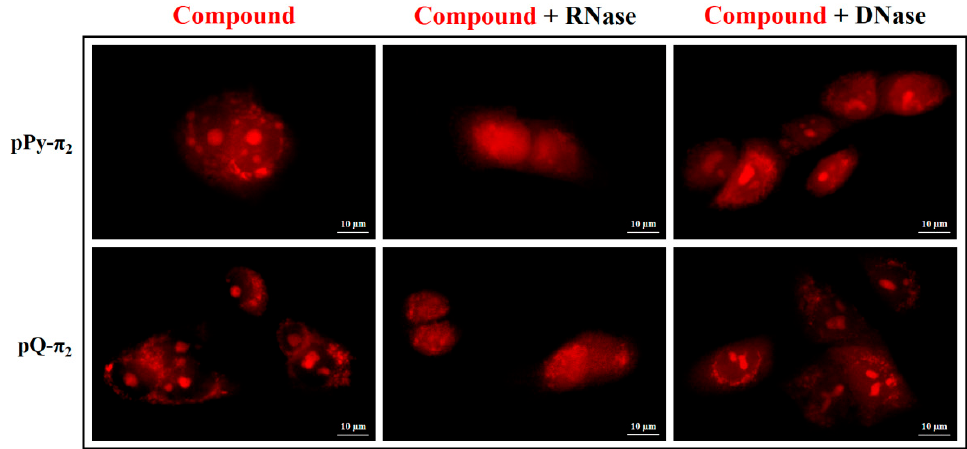
Figure 7. Representative fluorescence microscopy images of fixed and permeabilized A549 cells stained with 10 µM pPy- π 2 and pQ- π 2 compounds (red, TRITC filter) before and after treatment with RNase and DNase. Image magnification: 60×.